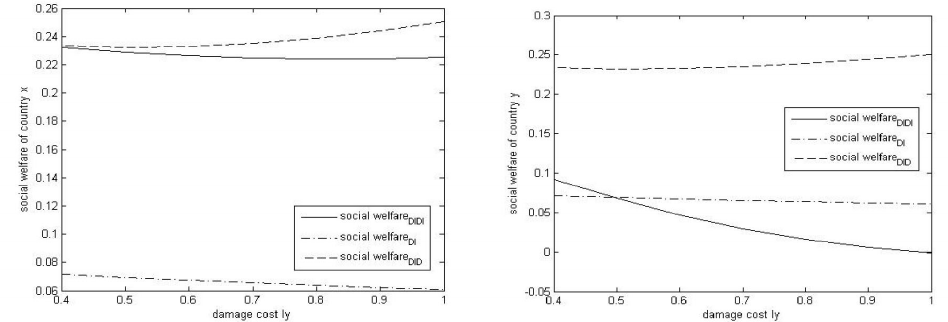
Figure 3. The comparison of R x and R y between scenario DIDI, DI and DID ( l x = 0.25 l y